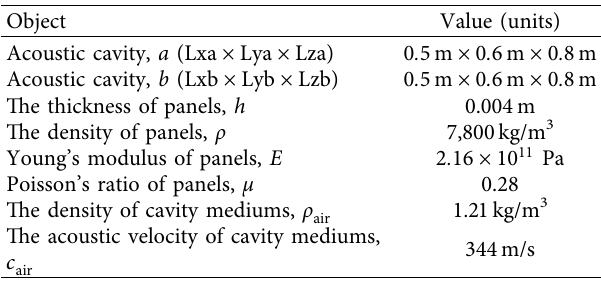
Table 1: Geometric parameters and material properties of the stiffened double panel-cavity coupled